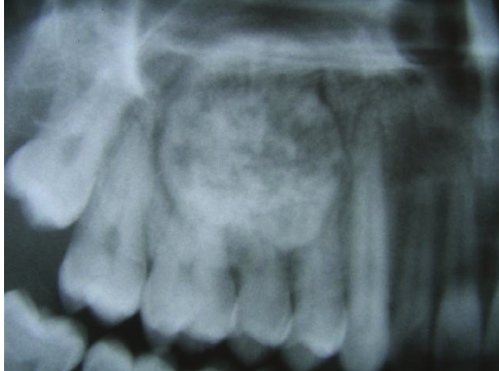
Figure 3: Radiograph showing the extent of lesion.